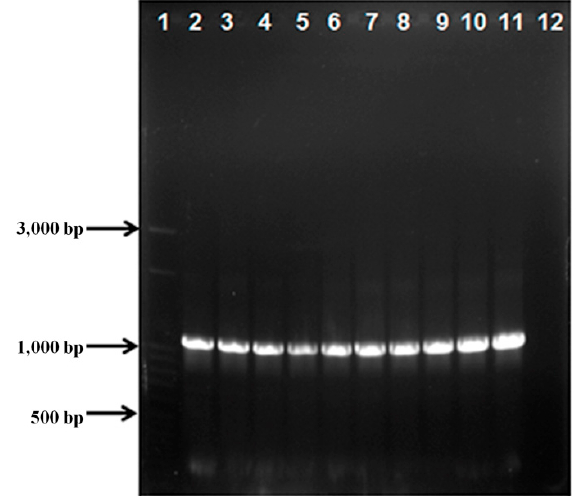
Figure 2. Colony PCR for pTXB1-MnP1 candidates. 1. MWM 50 bp step ladder; 2 − 11. Candidates; 12. Empty vector.